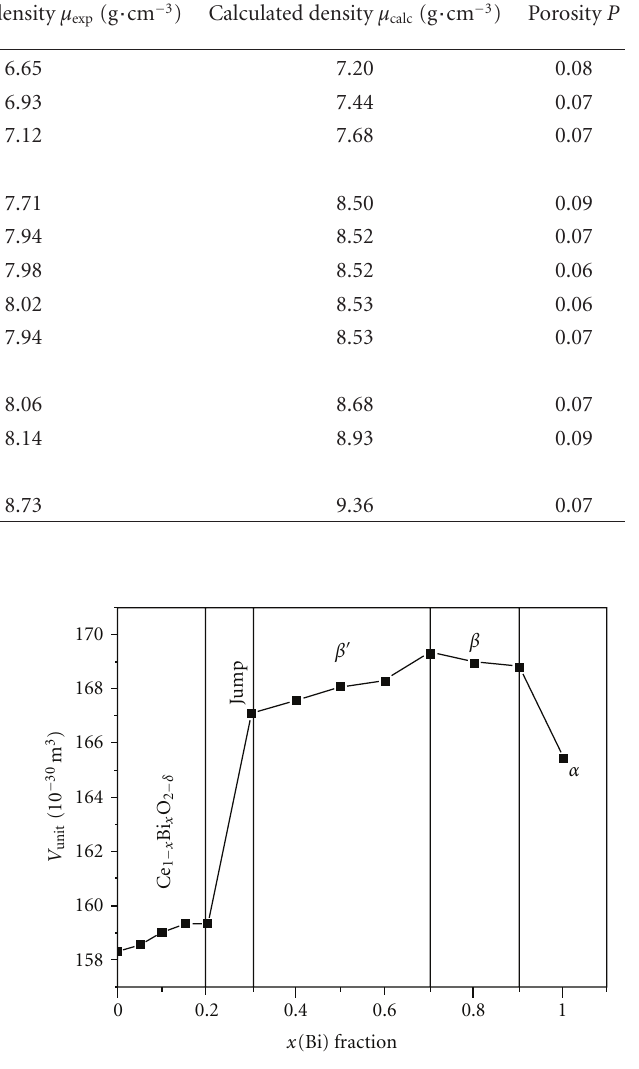
Figure 1: Variation of the A 4 O 8 unit volume V unit versus bismuth fraction x (from [1]). (1): for 0 ≤ x ≤ 0 . 2, Ce 4 O 8 unit for the solid solution Ce (1 − x ) Bi x O (2 − δ ) . (2): for 0 . 3 ≤ x ≤ 0 . 7, Bi 4 O 6 (cid:2) 2 unit for the tetragonal β (cid:4) phase. (3) for 0 . 7 < x < 0 . 9, Bi 4 O 6 (cid:2) 2 unit for the tetragonal β phase. (4) for x = 0 . 7 maximum of conduction due to the tetragonal phase. (5) for x = 1, Bi 4 O 6 (cid:2) 2 unit for the monoclinic α